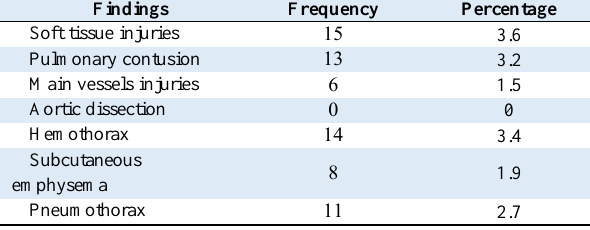
Percentage Frequency